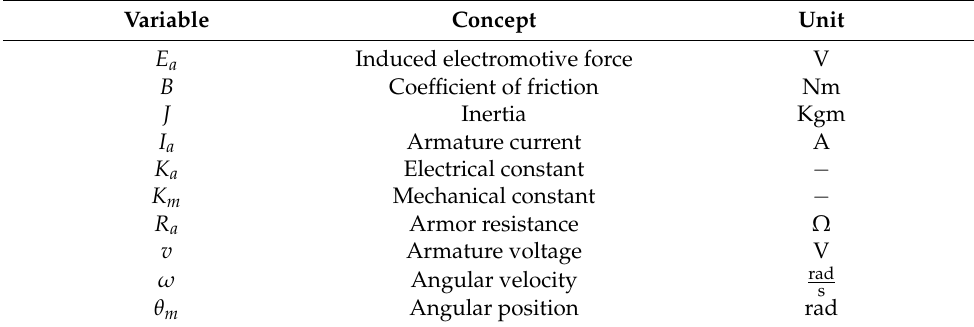
Figure 2. Scheme diagram of the DC motor. The heuristically obtained values used for this model are: J = 0.01 Kgm K m , a = 0.01, R = 1 Ω , L = 0.5 H . The Table 1 shows a summary of the variables used for the engine model and their description. Table 1. Variables used in the DC motor model.